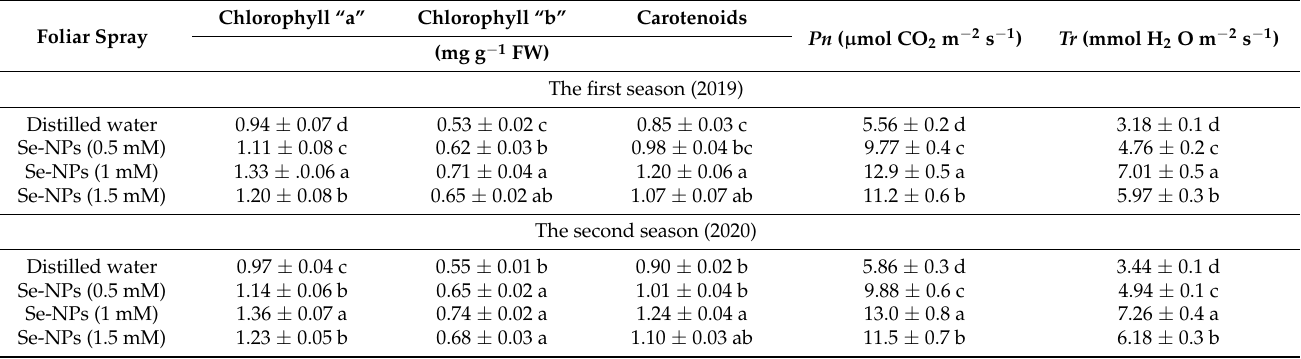
Table 4. Photosynthetic efficiency responses of salt-stressed common bean plants (soil EC = 7.55–7.61 dS m − 1 ) to foliar nourishment with selenium dioxide nanoparticles (Se-NPs) in two consecutive seasons.